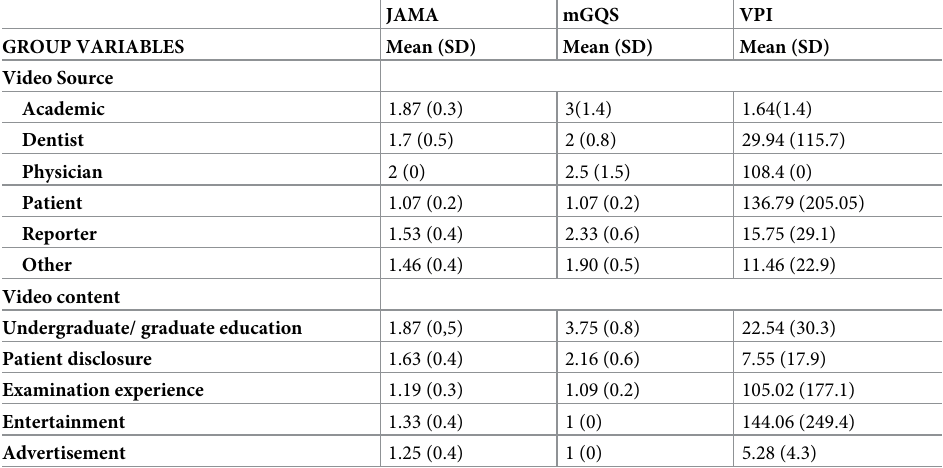
Table 4. Quality and reliability scores of reviewed YouTube videos according to video source and content. JAMA